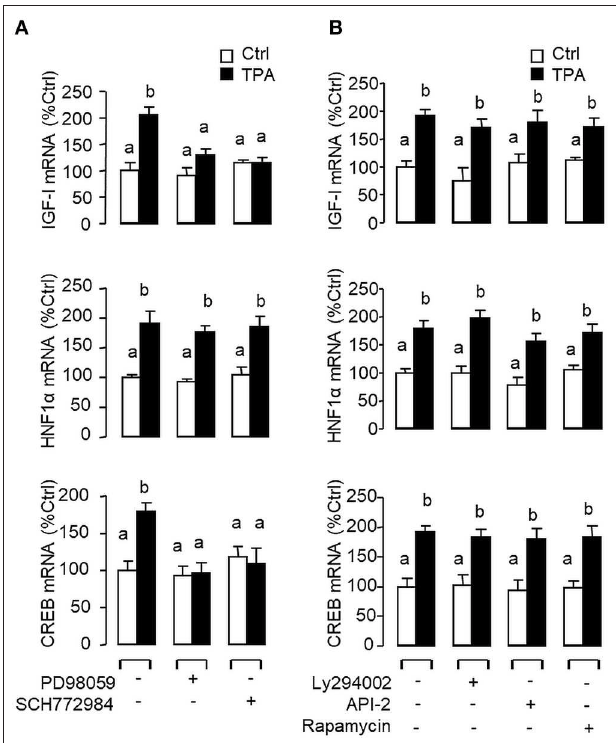
FIGURE 9 | Functional coupling of MAPK and PI3K/Akt cascades with PKC activation in IGF-I, HNF1 α , and CREB mRNA expression at the hepatic level. Carp hepatocytes were exposed to the PKC activator TPA (10 µ M) for 12h in the presence of (A) the MEK 1 / 2 inhibitor PD98059 (10 µ M) or ERK 1 / 2 inhibitor SCH772984 (10nM), or (B) the PI3K inhibitor Ly294002 (10 µ M), Akt blocker API-2 (2 µ M), or mTOR inactivator Rapamycin (20nM). After that, total RNA